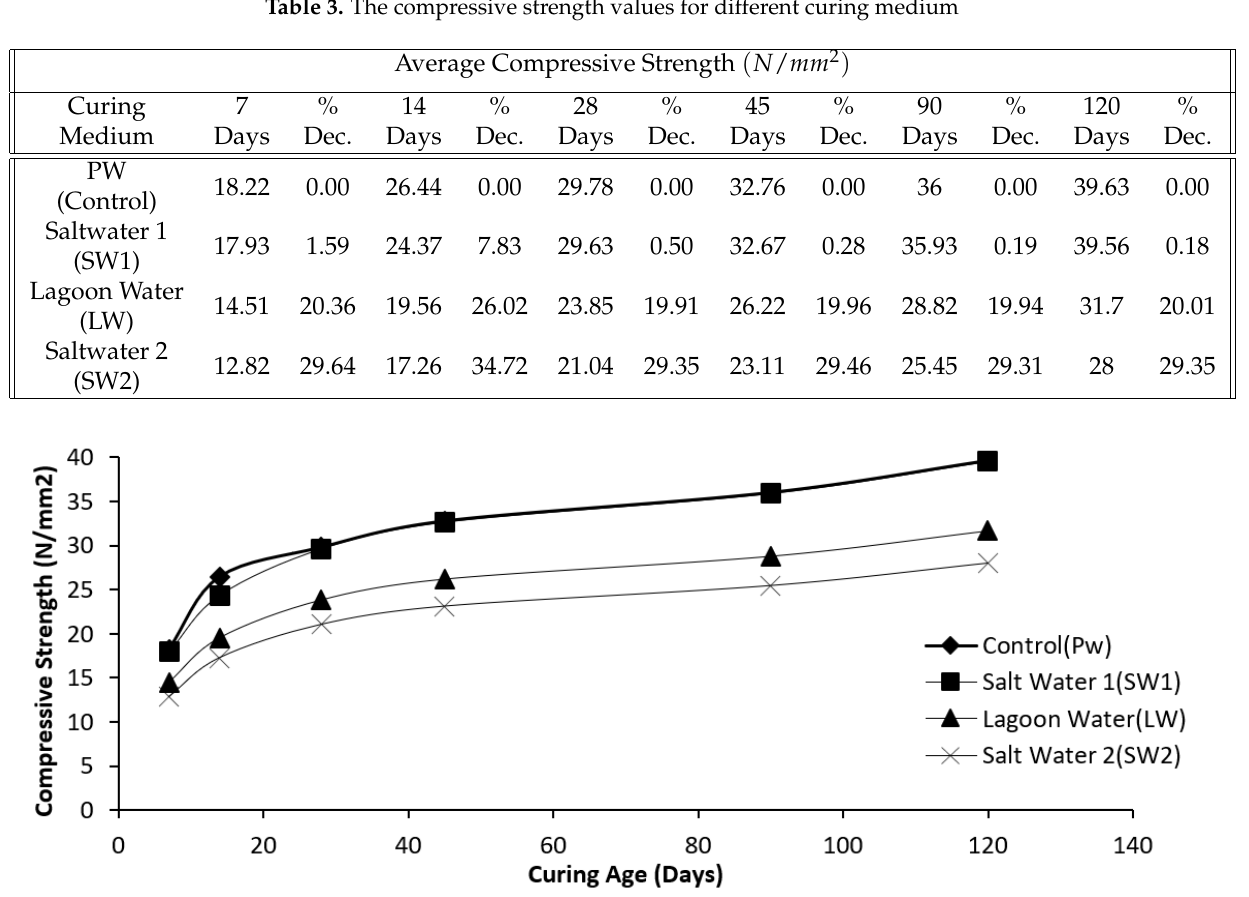
Table 3. The compressive strength values for different curing medium